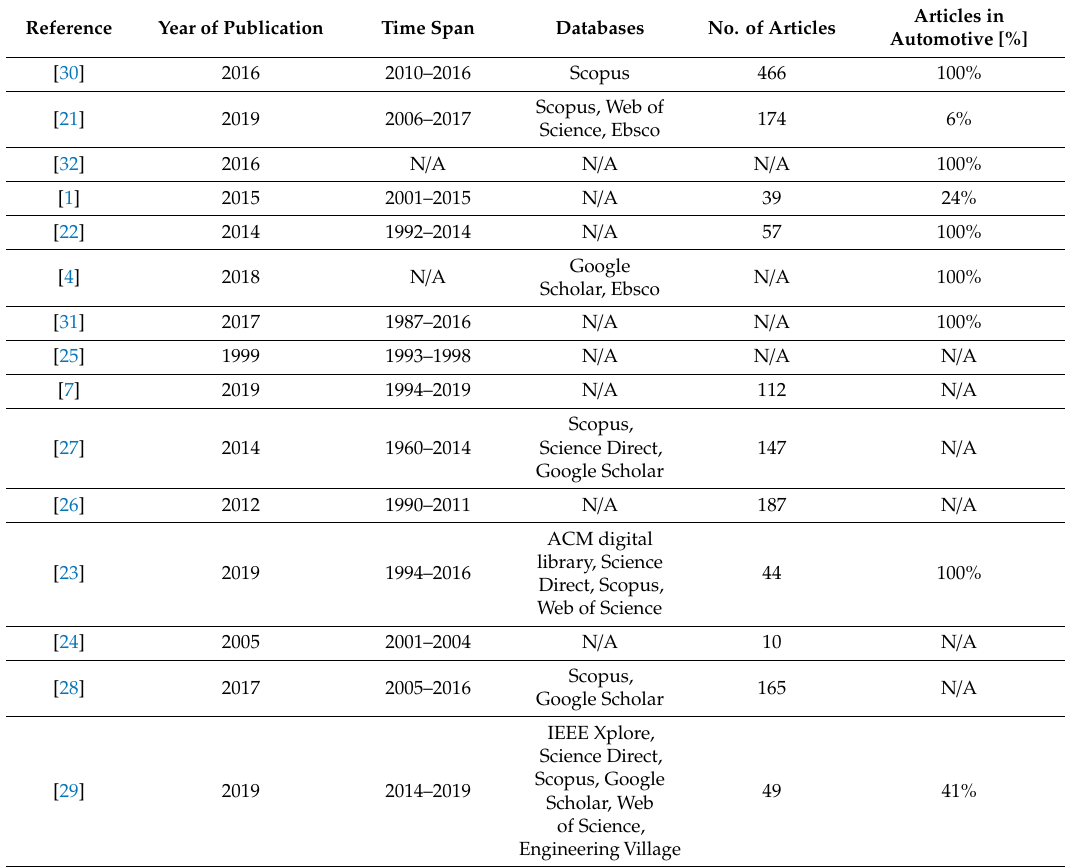
Table 1. List of review